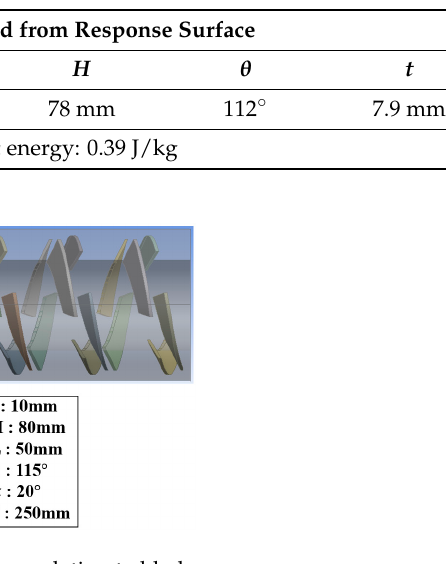
Figure 18. Verification of candidate point recommended from response surface.